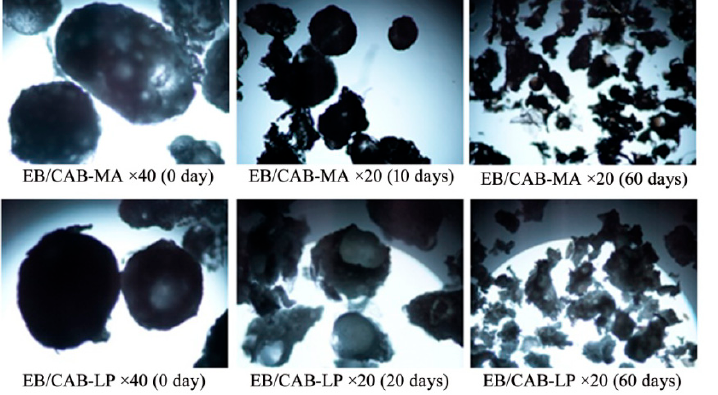
Figure 9. The optical photographs of EB/CAB-MA and EB/CAB-LP microspheres during the degradation process.